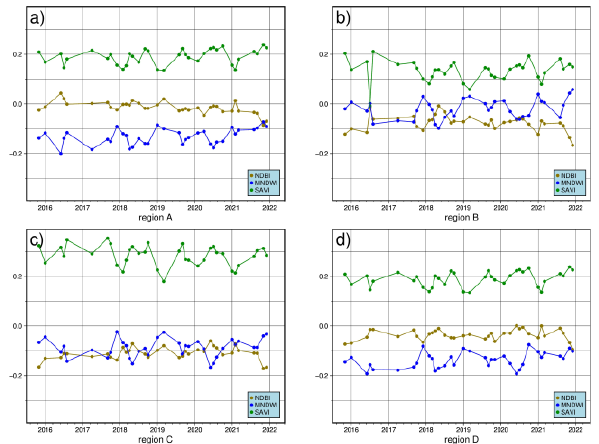
Figure 5 . Time series of SAVI 、 NDBI and MNDWI for the four areas.